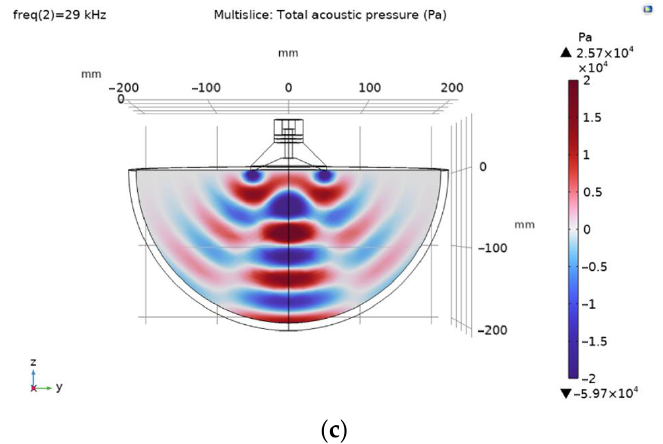
Figure 7. Propagation of an acoustic field generated by piezoelectric transducer at the first mode in the muscle: ( a ) with flat surface; ( b ) with 58 mm diameter ring-shaped surface; ( c ) with 100 mm diameter ring-shaped surface.